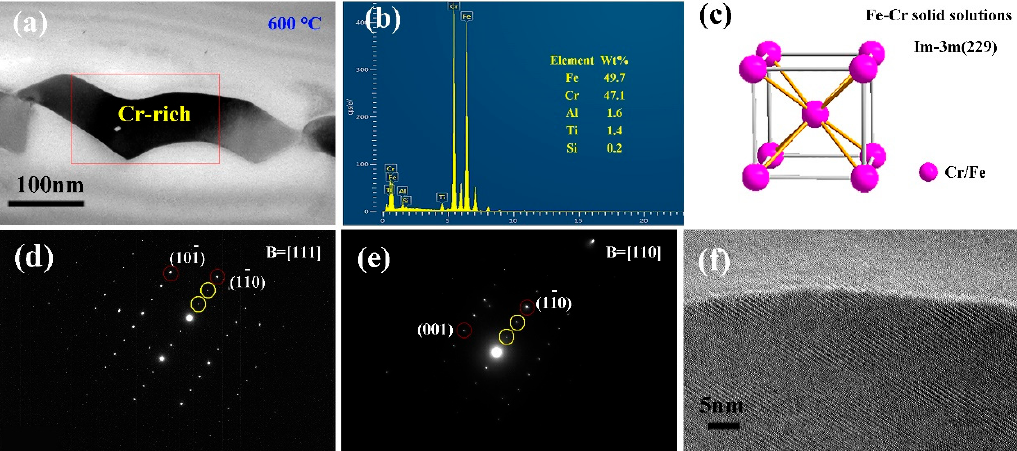
Figure 6. TEM morphology of rolled and heat-treated Fe-25Cr-5Al-RE wire rods at 600~1000 °C for 60 min. ( a ): rolled; ( b ): 600 °C; ( c ): 700 °C; ( d ): 800 °C; ( e ): 900 °C; ( f ): 1000 °C.